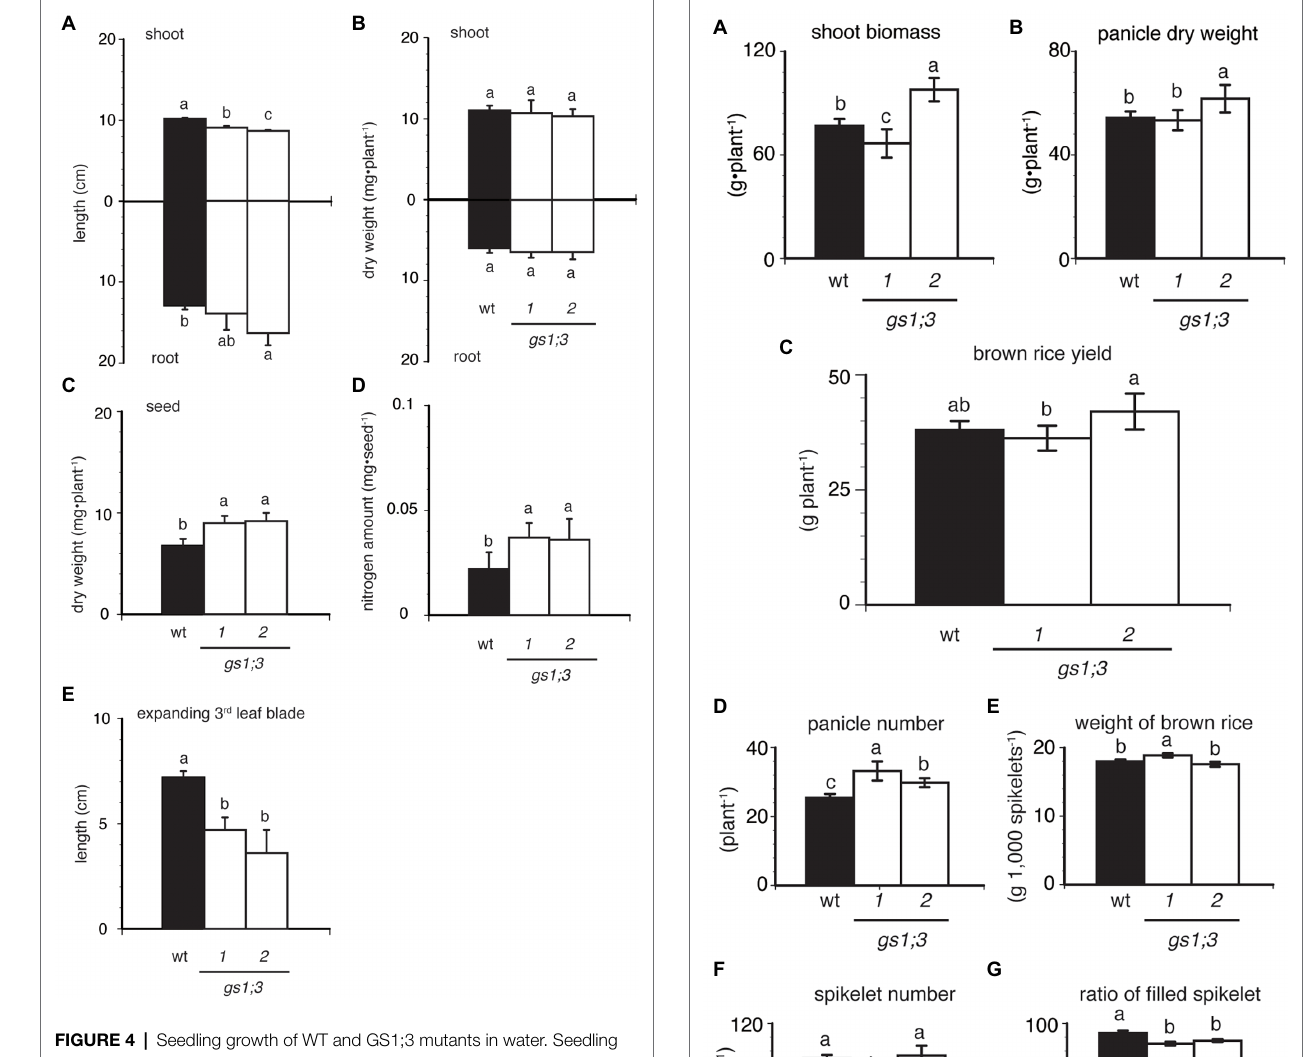
FIGURE 4 | Seedling growth of WT and GS1;3 mutants in water. Seedling growth of WT and GS1;3 mutant plants cultured for 21 days in water. (A) root and shoot length, (B) root and shoot dry weight, (C) seed dry weight, (D) seed nitrogen amount after 21 days, and (E) third leaf blade length. Data represent mean ± SD ( n = 5). Significant differences within each group were determined using one-way analysis of variance (ANOVA) followed by Bonferroni tests and are indicated with different letters ( p < 0.05).